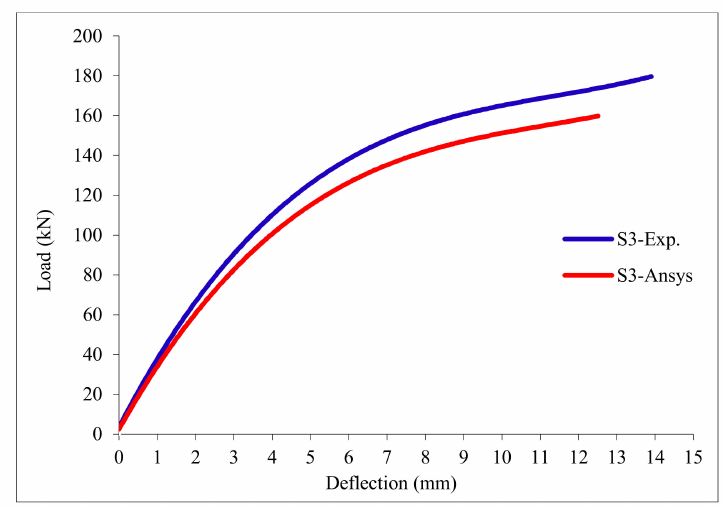
Figure 28. Load deflection curve for control slab